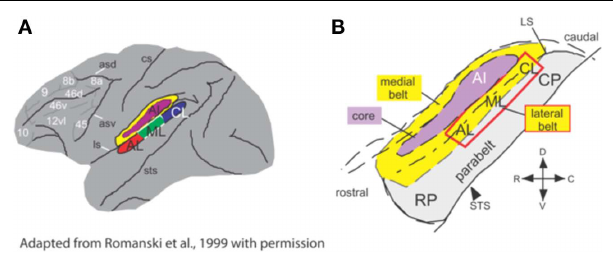
FIGURE 1 |Anatomical regions of non-human primate (monkey) brain involved in processing of spatial and non-spatial stimuli. (A) Lateral belt region (in color) comprises A1, primary auditory cortex; CL, caudolateral belt region; AL, anterolateral belt region; ML, medial lateral belt region. (B) The same region, enlarged to show the locations of the medial and lateral belt (yellow), primary auditory cortex (purple) and the parabelt cortex on the superior temporal gyrus. Adapted from Romanski et al. (1999), with permission.